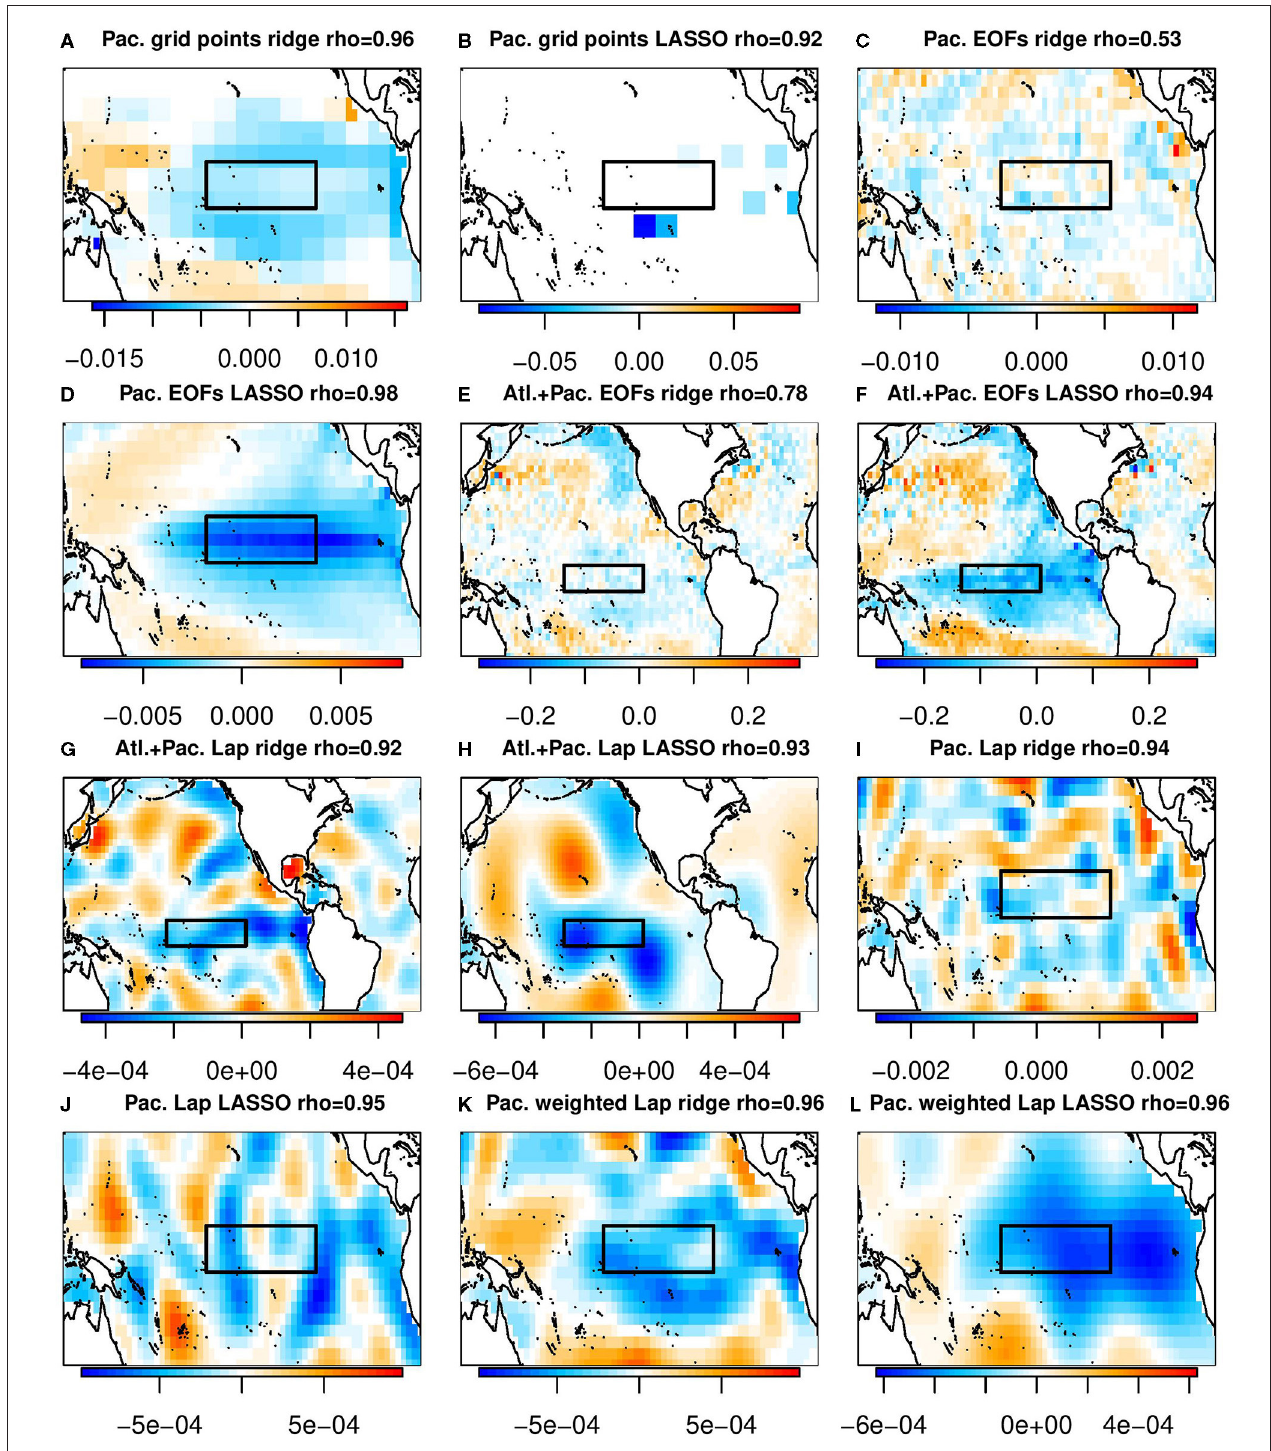
FIGURE 4 | The β coefficients selected by various machine learning algorithms. Titles of the individual panels indicate the domain, basis set, machine learning algorithm used, and the correlation between the resulting prediction and the Nino3.4 index. The black boxes indicates the Nino3.4 index. (A) Pac. grid points ridge rho = 0.96. (B) Pac. grid points LASSO rho = 0.92. (C) Pac. EOFs ridge rho = 0.53. (D) Pac. EOFs LASSO rho = 0.98. (E) Alt+Pac. EOFs ridge rho = 0.78. (F) Alt+Pac. EOFs LASSO rho = 0.94. (G) Alt+Pac. Lap ridge rho = 0.92. (H) Alt+Pac. Lap LASSO rho = 0.93. (I) Pac. Lap ridge rho = 0.94. (J) Pac. Lap LASSO rho = 0.95. (K) Pac. weighted Lap ridge rho = 0.96. (L) Pac. weighted Lap LASSO rho = 0.96.